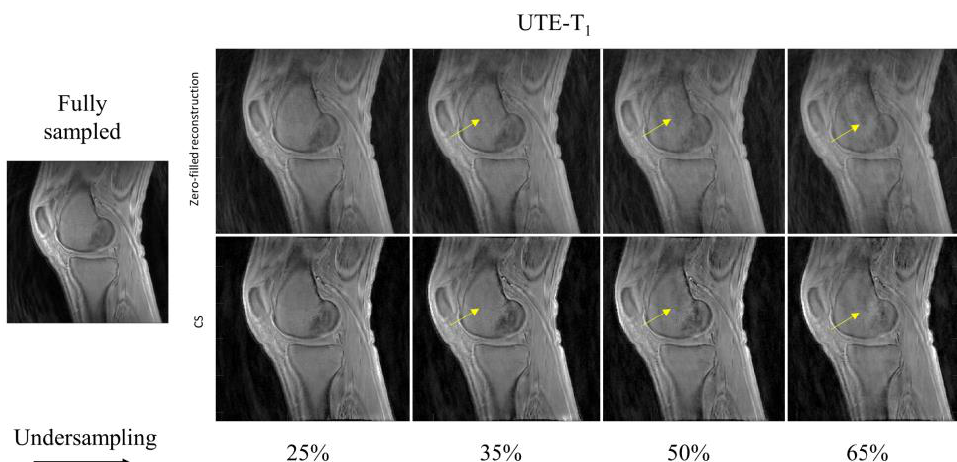
Figure 2. Comparison of UTE-T 1 -reconstructed images at different undersampling rates between zero-filled reconstruction and CS-based reconstruction. Reference image on the left was reconstructed using fully sampled k-space data. Yellow arrows indicate reconstruction error prevalent on zero-filled reconstruction ( top row ) and the reduced artifacts in the CS-based reconstruction ( bottom row ).